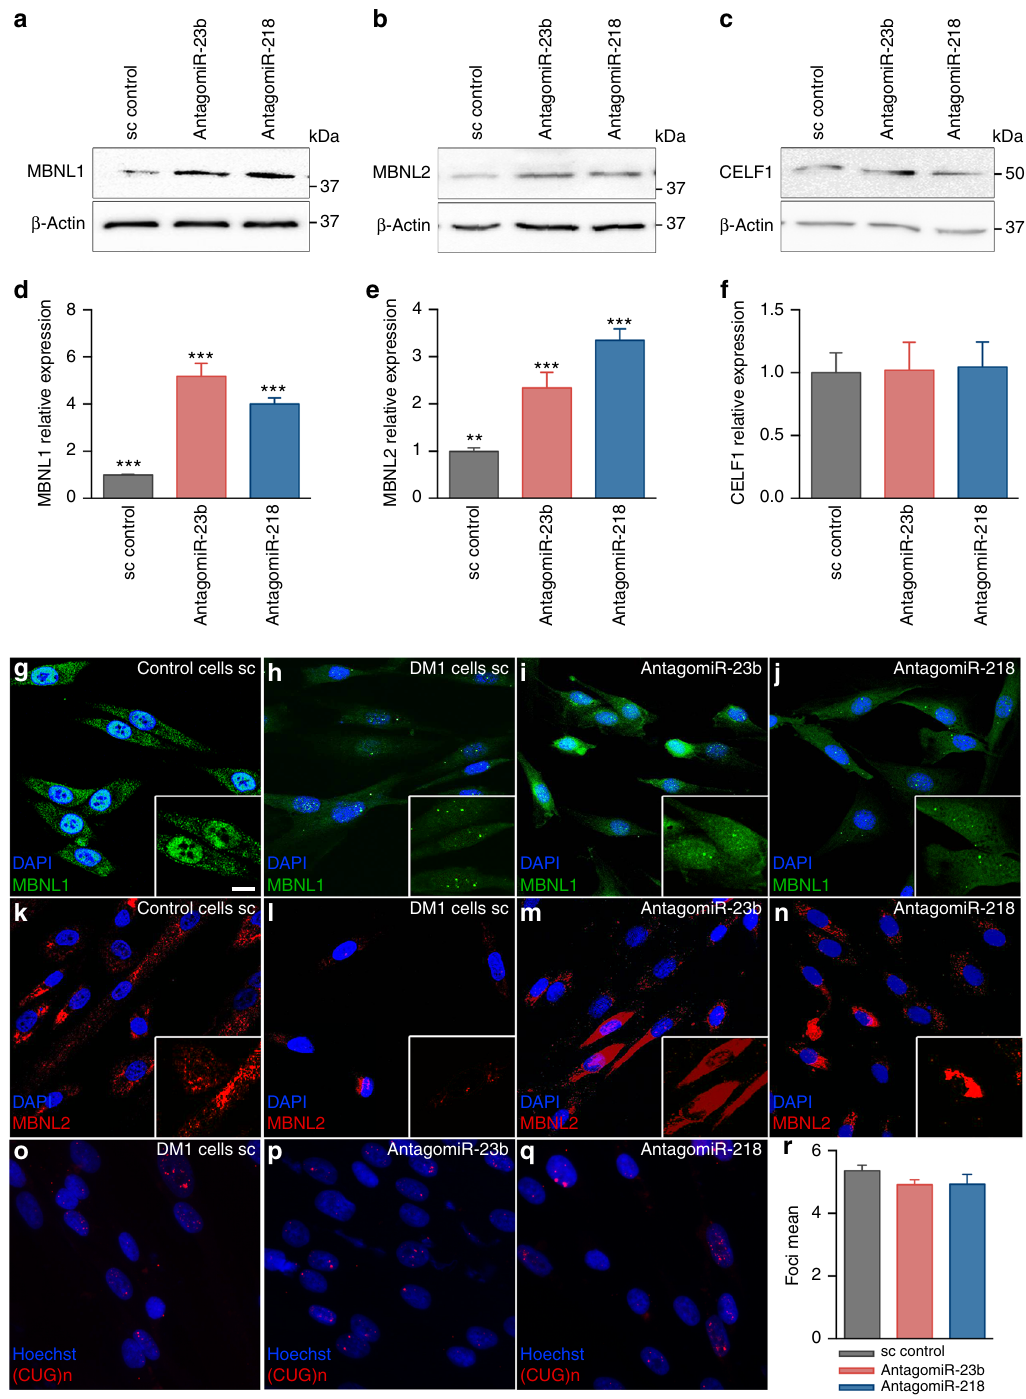
Fig. 4 Increase of MBNL1 and MBNL2 upon silencing of miR-23b or miR-218 in human myoblast. a – f Western blot quanti fi cation of MBNL1 ( a , d ), MBNL2 ( b , e ), and CELF1 ( c , f ) expression levels in DM1 human myoblast 96 h after transfection with 50 nM of antagomiR-23b, 200 nM of antagomiR-218 or a scrambled control antagomiR (sc). β -ACTIN expression was used as endogenous control ( n = 3). Data are mean ± SEM. ** p < 0.01, *** p < 0.001 in Student ’ s t test. g – n Representative confocal images of MBNL1 (green) and MBNL2 (red) staining in healthy controls (control cells) and DM1 human myoblast 96 h after transfection with antagomiRs against miR-23b (50 nM) or miR-218 (200 nM) and a scrambled control antagomiR (DM1 cells). Nuclei were counterstained with DAPI (blue). In DM1 cells, endogenous MBNL1 ( h ) and MBNL2 ( l ) were in nuclear aggregates (green and red puncta) and the total amount of both was reduced compared to control cells ( g ) and ( k ), respectively. In contrast, DM1 cells treated with antagomiRs against miR-23b or miR-218 showed a robust increase in cytoplasmic and nuclear MBNL1 ( i , j ) and MBNL2 ( m , n ) levels compared to DM1 cells. b – q Representative fl uorescence of FISH images showing (CUG)n RNA foci (red) in DM1 human fi broblasts transfected with antagomiRs against miR-23b (50 nM) or miR-218 (200 nM) and a scrambled control antagomiR. Nuclei were counterstained with Hoechst (blue). AntagomiRs did not signi fi cant change the number of ribonuclear foci in DM1 fi broblasts ( r ). Scale bar = 20 μ